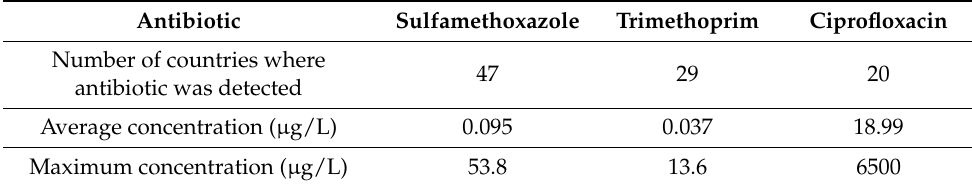
Table 1. Concentrations of SMX, TMP and CIP detected in surface waters